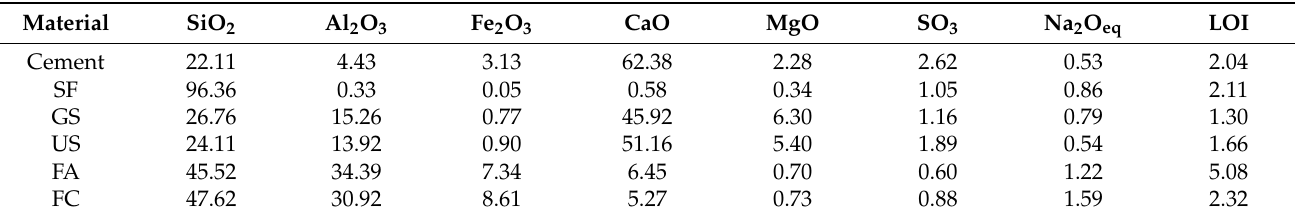
Table 1. Chemical compositions of cement and mineral admixtures w /%.